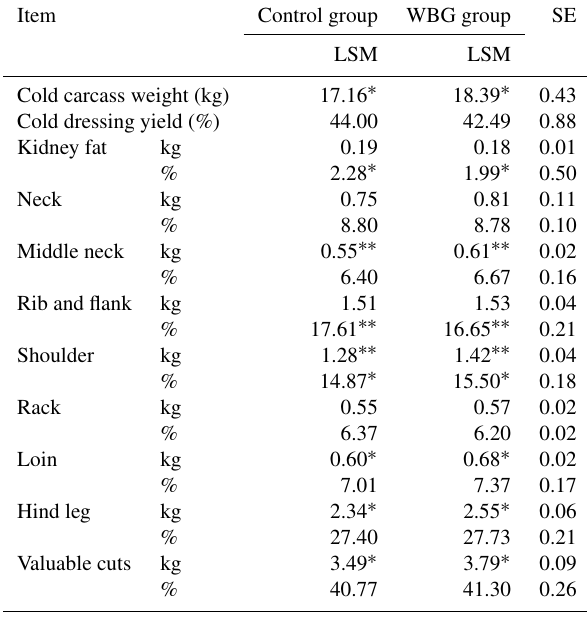
Table 2. Fattening results of the control and the WBG lambs. Item Control group